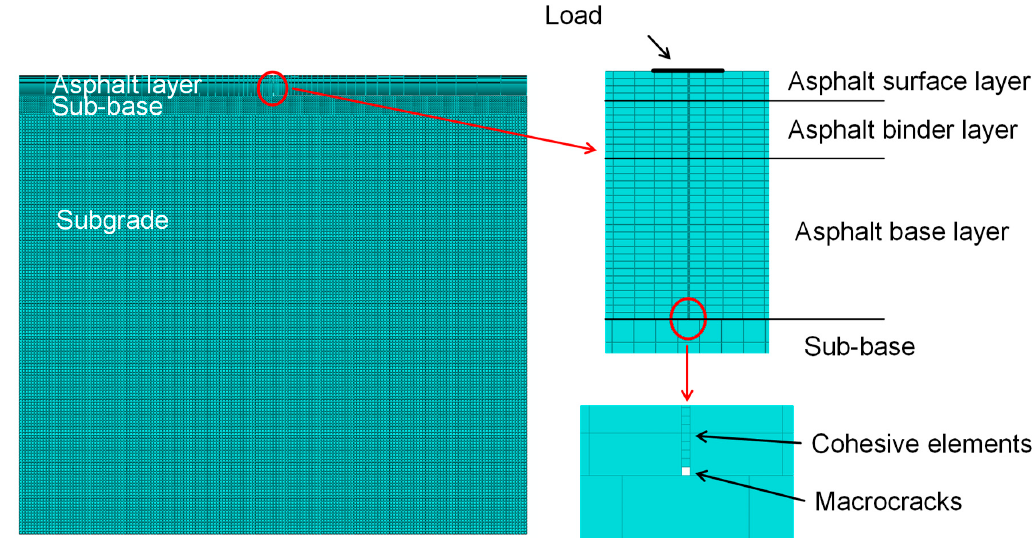
Figure 9. Model of the asphalt pavement.